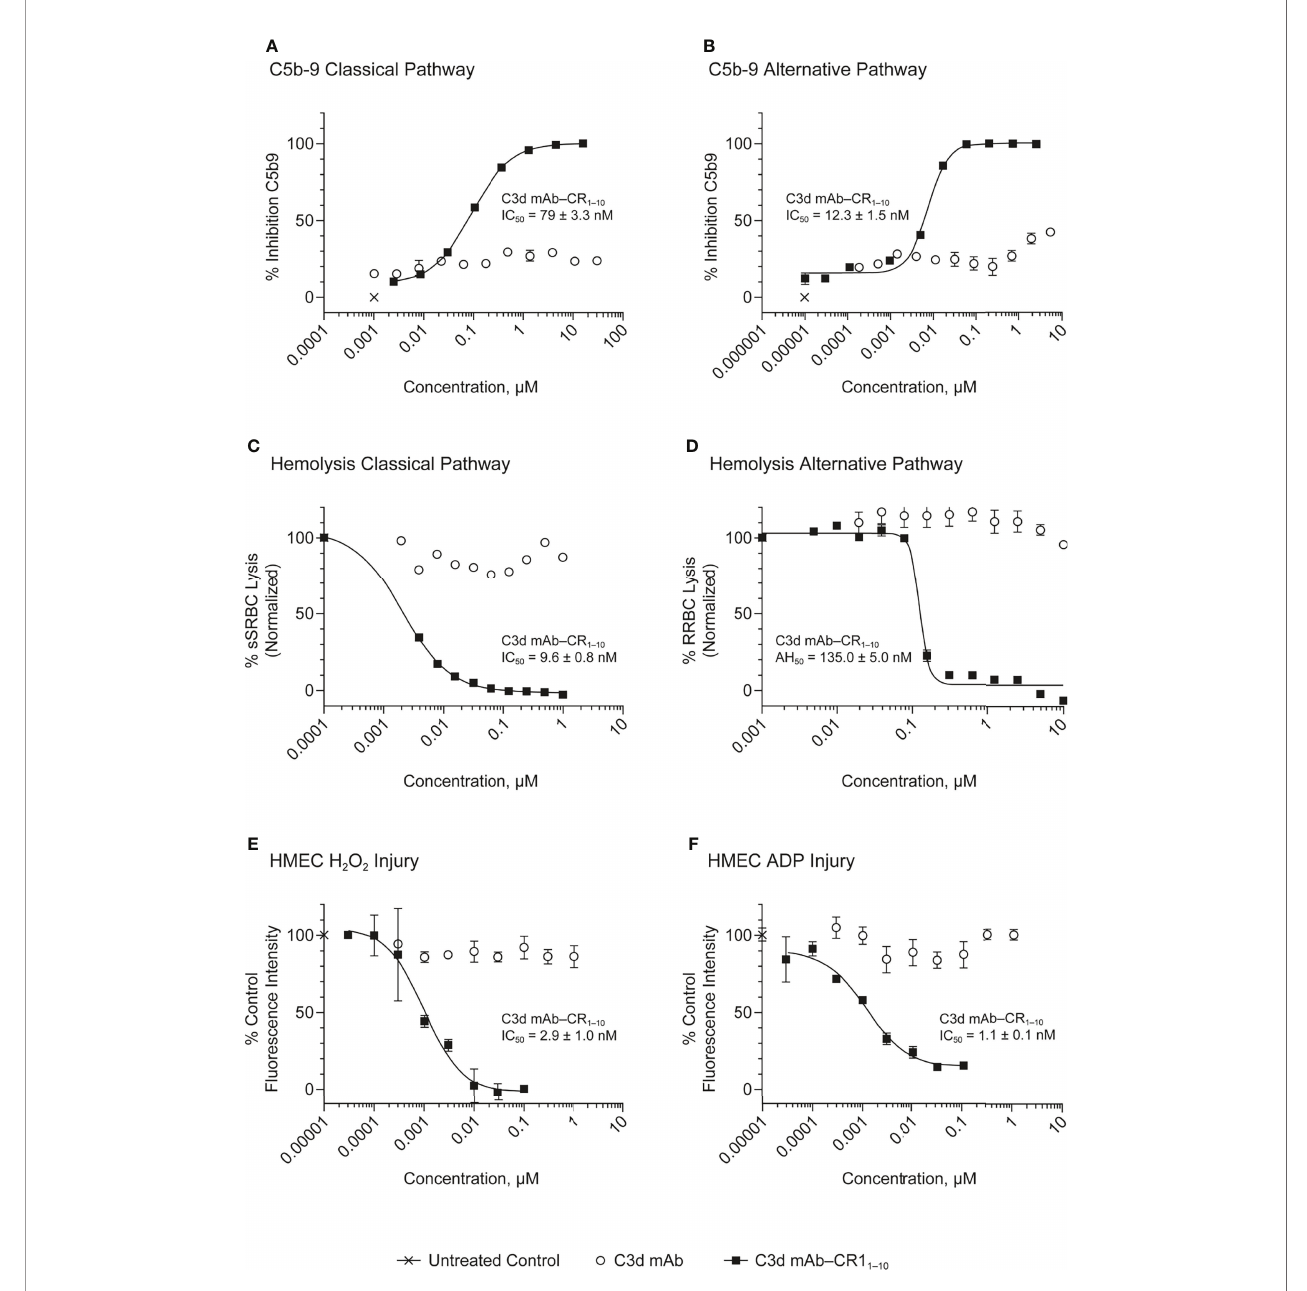
FIGURE 5 | Dose response curves for C3d mAb − CR1 1-10 and parent C3d mAb, 3d8b, in complement activation assays. (A) C5b-9 Classical Pathway (ELISA), (B) C5b-9 Alternative Pathway (ELISA), (C) Hemolysis Classical Pathway, (D) Hemolysis Alternative Pathway, (E) HMEC H2O2 Injury, (F) HMEC ADP Injury. Complement inhibitory activity is shown for C3d mAb – CR1 1-10 (closed squares), C3d mAb (open circle) and an untreated control sample (X). The HMEC assay was carried out with either H 2 0 2 or ADP induced injury. Replicate data are shown as mean values plus SEM. Half-maximal inhibitory concentrations in each assay are provided for C3d mAb − CR1 1-10